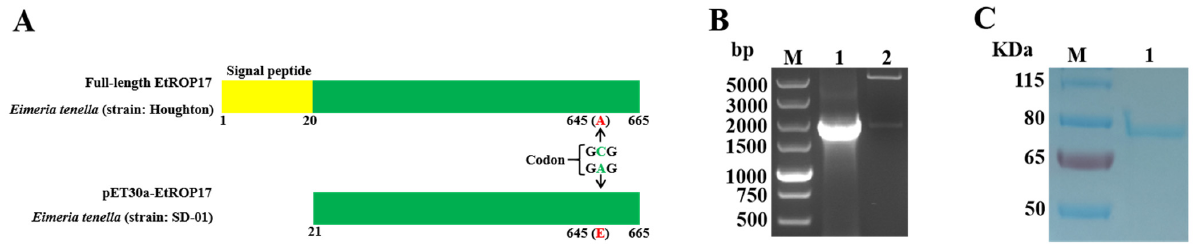
Figure 1. ( A ) The region of EtROP17 used for expression: the C to A transition at nucleotide 1901 converted the amino acid alanine (position 645) to amino acid glutamic acid. ( B ) Lane M: DL5000 DNAmarker; lane1: thegenefragmentofEtROP17amplifiedfrom E.tenella cDNA;lane2: therecombinant plasmid was identified by digestion. ( C ) Lane 1: SDS-PAGE analysis of purified